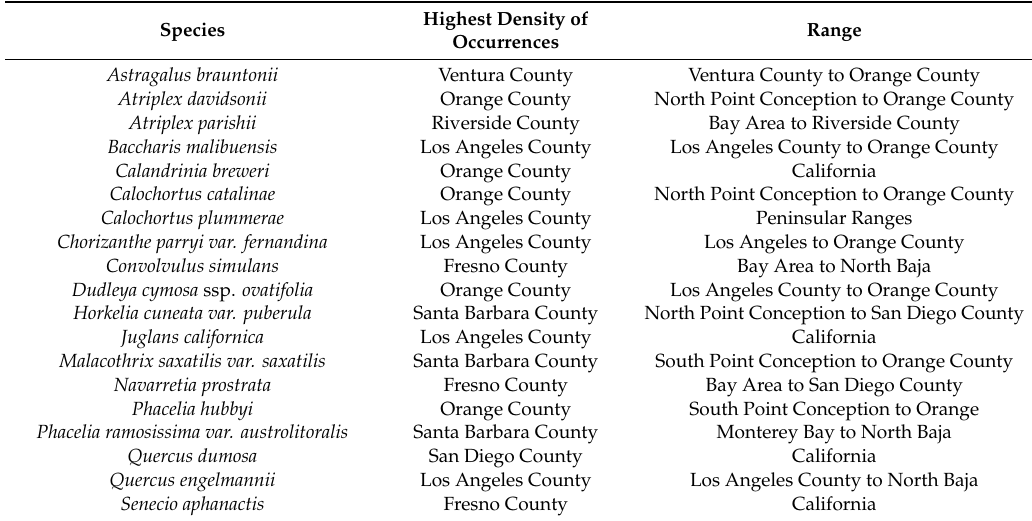
Table A2. Rare Species that occur within the NCC Reserve System and have their Southern ranges extend into Orange County.